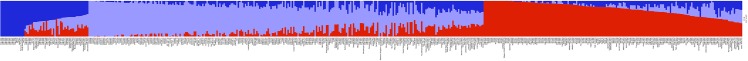
Admixture analysis based on three hypothetical founder populations.Dark blue represents African introductions, light blue represents Brazilian founder populations and red represents founders within the IITA breeding program.